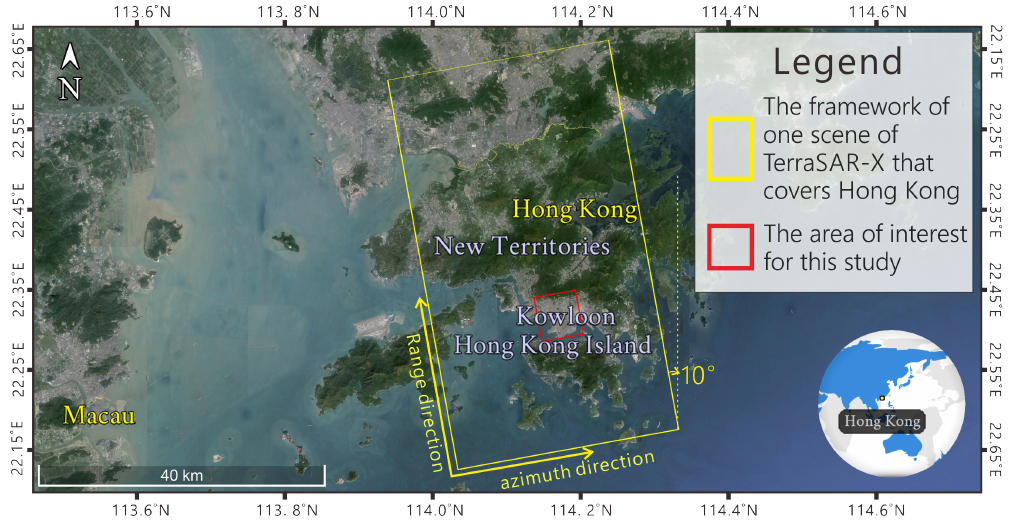
Figure 1. The area of interest (AOI) for the study, which covers the majority of urban Hong Kong.